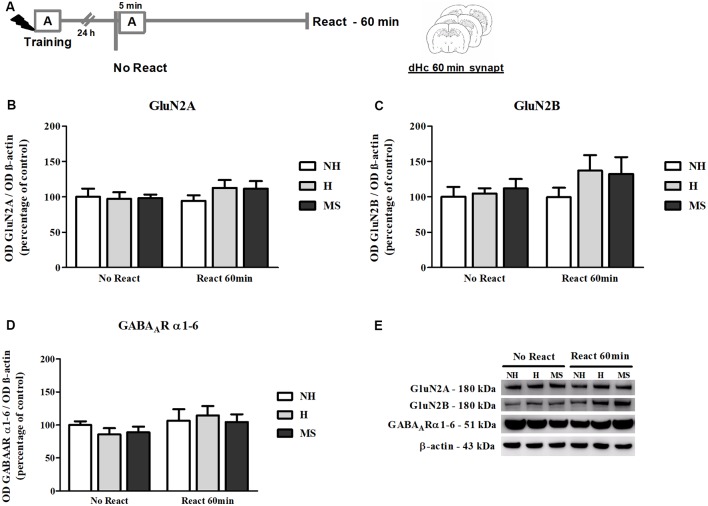
NMDAR subunits GluN2A and GluN2B and GABAAR α1–6 subunits immunocontent in the dHc synaptosome membrane fraction (synapt) of adult male rats that were non-handled (NH) or subjected to handling (H) or maternal separation (MS) in the neonatal period, 60 min after Reactivation (React) compared to trained animals that were not re-exposed to the training context (No React). No significant changes in N-Methyl-D-aspartate (NMDA) or GABAAR subunit composition were found in the dHc. (A) Schematic diagram of the experimental design; (B) GluN2A; (C) GluN2B; (D) GABAAR α1–6 subunits; (E) representative Western blot bands. Data are expressed as mean ± SEM. n = 5–7/group. 2w-ANOVA was used for statistical analyses. Statistics results are presented in detail in subsection “Synaptic NMDA and GABAAR Subunits Were not Changed by Memory Reactivation in the dHc.”